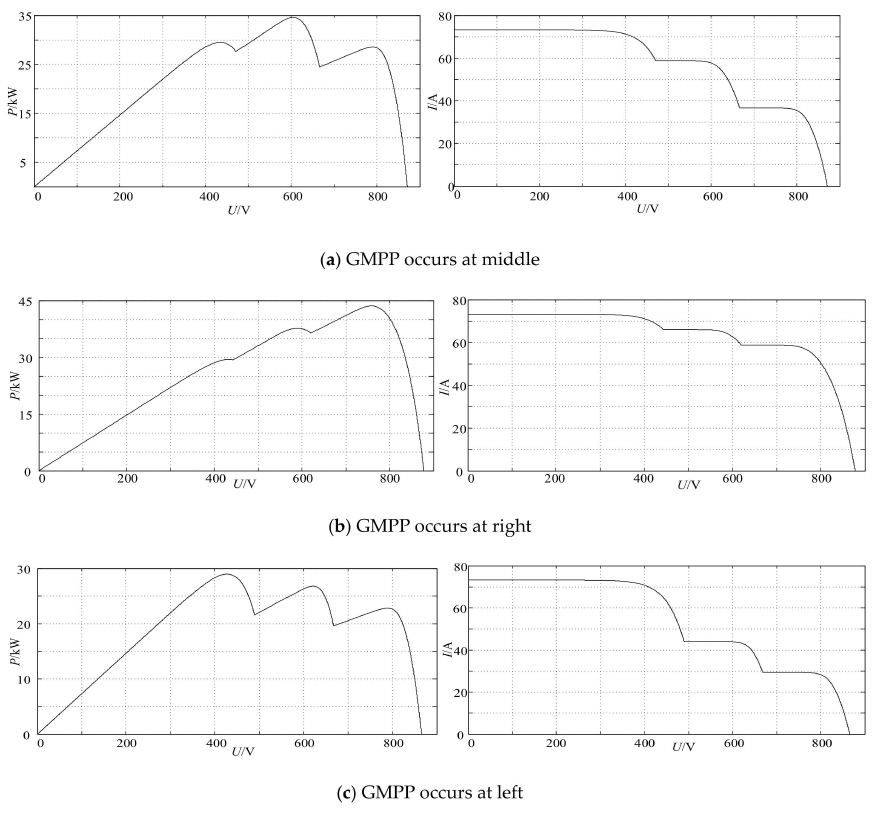
Figure 5. Di ff erent P – V curves under various